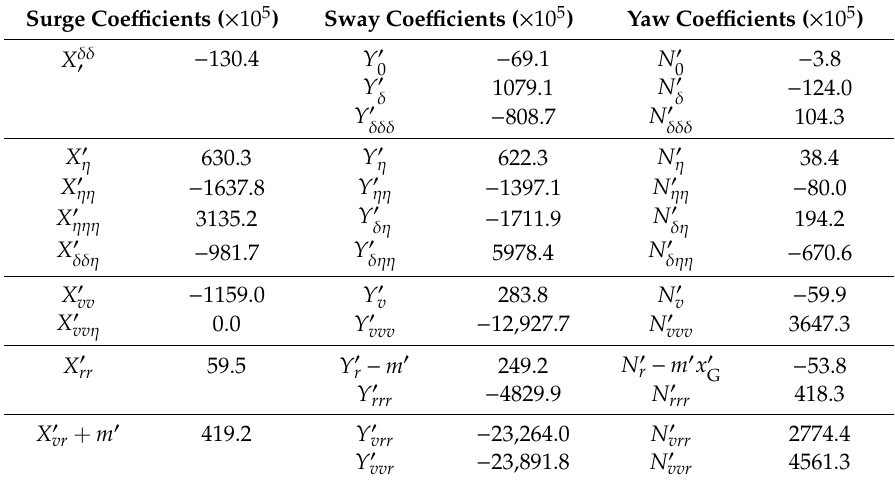
Table 3. Identification results of non-dimensional surge, sway and yaw hydrodynamic coe ffi cients for Yukun ship model.